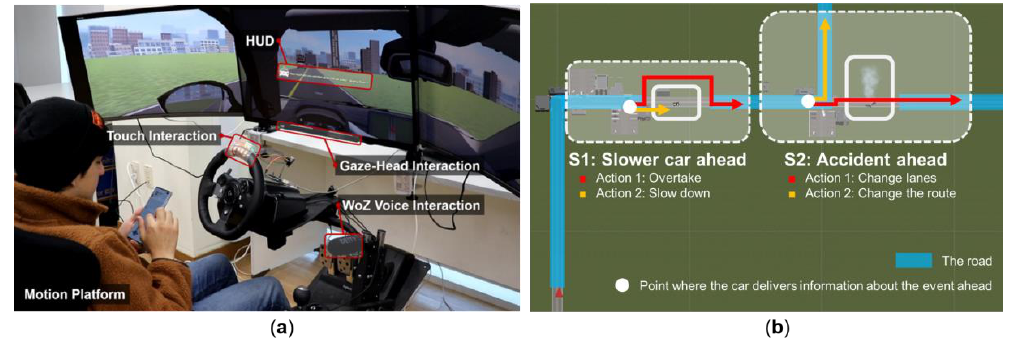
Figure 1. Experiment setup ( a ) Simulation environment (motion platform, full windshield head-up display (HUD); gaze-head input interaction (eye-tracker); touch input interaction (touch panel); voice input interaction (microphone); participant reading from a smartphone (non-driving related task) while sitting in the autonomous vehicle (AV) simulator motion platform); ( b ) destination and 2D user interface map implemented in Unity that shows two driving scenarios and four AV actions (two actions for each scenario).